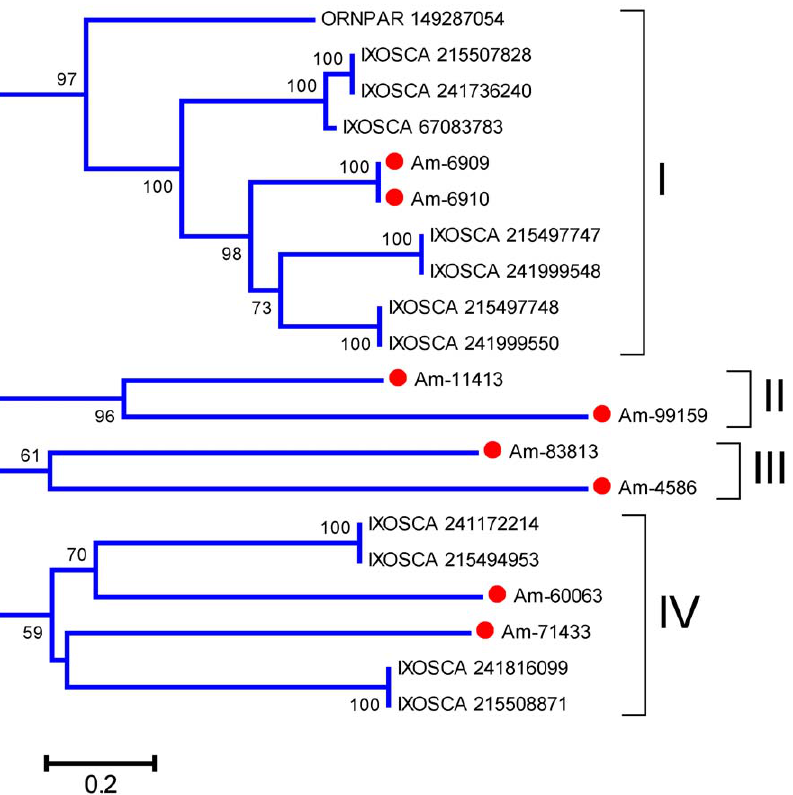
Figure 7. Phylogram of tick proteins from the 23-kDa family. The bootstrapped phylogram (1,000 iterations) was obtained from the alignment of deducted Amblyomma maculatum proteins with homologs found in the non-redundant protein database of the NCBI. The Am. maculatum protein names start with Am- and are recognized by a red circle marker; the remaining proteins are named by the first three letters of the genus name followed by the first three letters of the species name followed by their NCBI gi| accession number. The number at the nodes indicates the bootstrap support above 50%, and the bar at the bottom indicates 20% amino acid divergence. Clades and superclades with strong bootstrap support are indicated with Roman numerals.